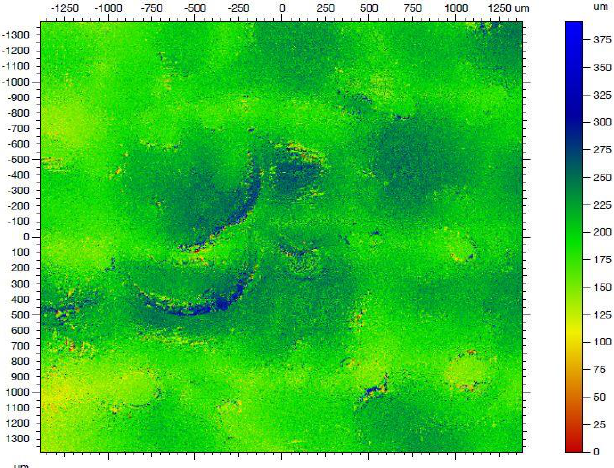
Figure 8. Surface morphology of the Cordura on a micrometer scale (confocal microscopy).